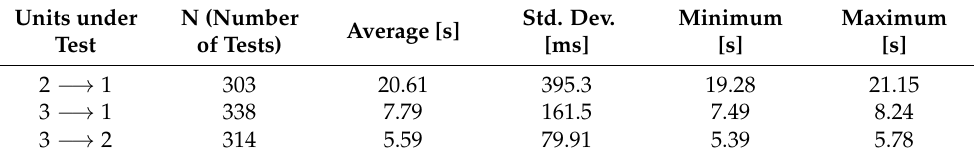
Table 1. Alignment test